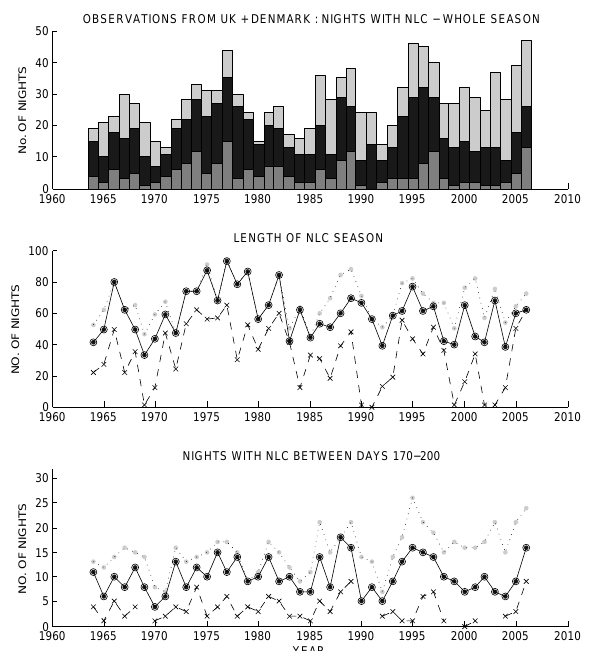
Fig. 1. Year-by-year characteristics of the UK/Denmark noctilucent cloud record. Top panel shows the number of nights each year when NLC were reported, for the whole season. Middle panel shows the length of the NLC season (the number of days between the first and last reported sightings). Bottom panel shows the number of nights with NLC reported during the core period of the season, the 30 nights between days 170–200 (20 June–20 July, 1 day earlier in leap years). Numbers are for all NLC reported (light gray, dotted lines), for a subset of reports where nights with only faint or very faint NLC are excluded (black, solid lines), and for nights when bright or very bright displays were reported (dark gray or crosses with dashed lines). The different histograms in the top panel are